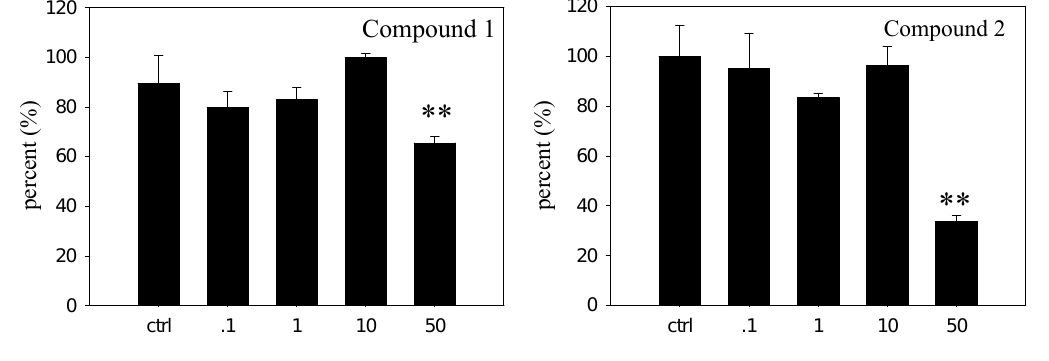
Figure 4 . Adherence inhibition activity against the marine microorganism P. pseudoalcaligenes by compounds 1-4 . Data were analyzed using one-way ANOVA, where ** P < 0.01 were significantly different from the